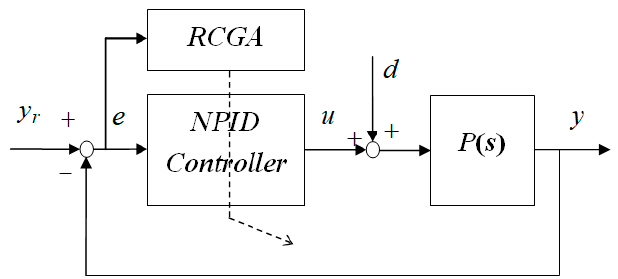
Figure 3. Tuning of the NPID controller with lead-lag compensator.